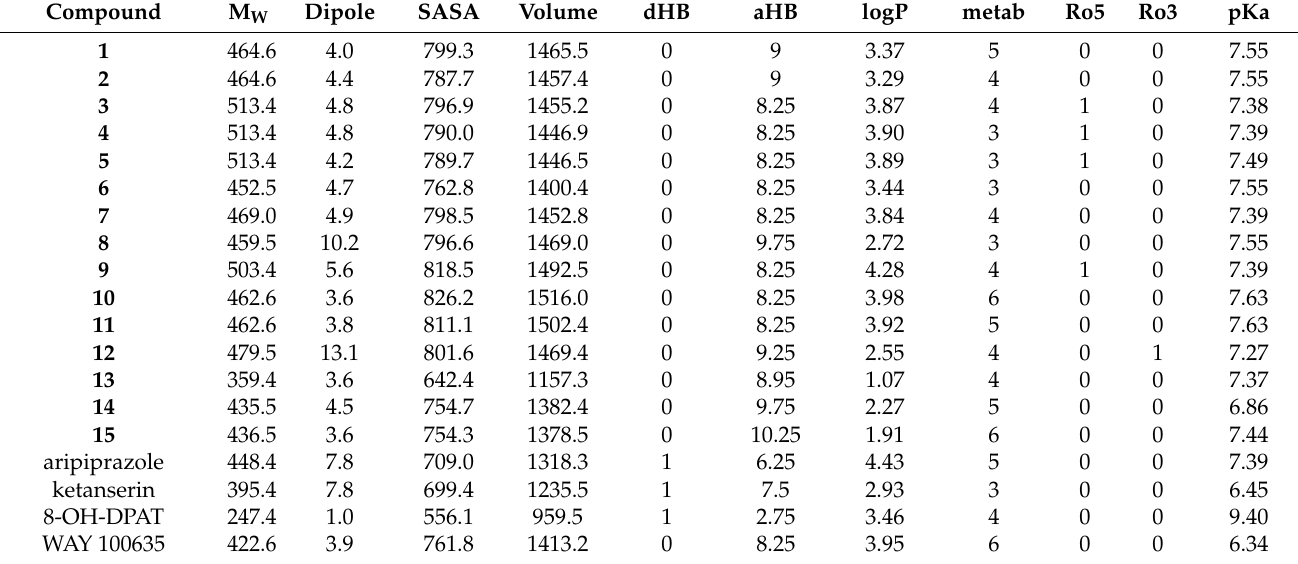
Table 2. Predicted ADME properties for compounds 1 – 15 .